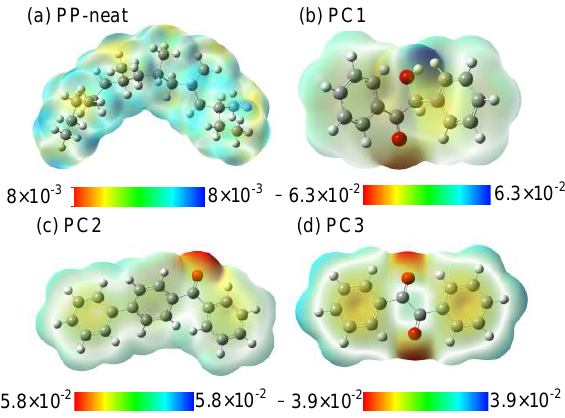
Figure 9. Three-dimensional (3D) electrostatic potential of samples, ( a ) PP-neat, ( b ) PC1, ( c ) PC2, and ( d ) PC3.